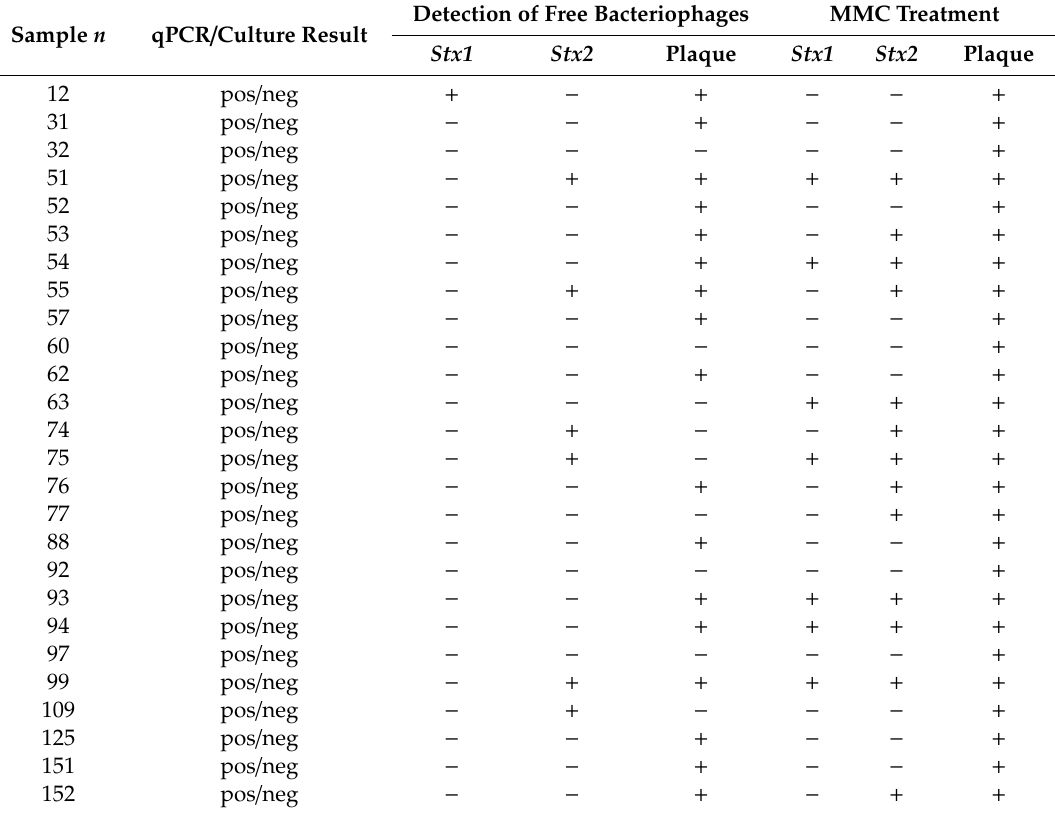
Table 2. Stx gene profiles, tested by qPCR, of the samples positive with the plaque assay. These include samples examined for free phage (Figure 1c) and for phage induction (Figure 1d).